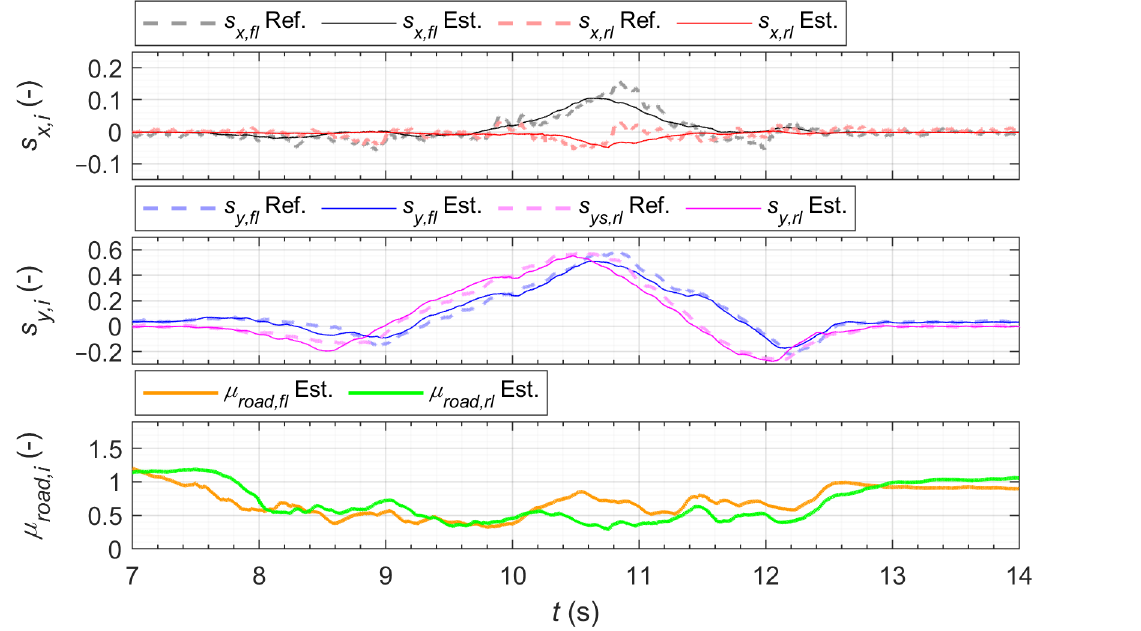
Figure 6. Test data—evasion maneuver on a wet road surface: measured and estimated tire slip for front left and rear left wheels as well as estimated tire model adaption